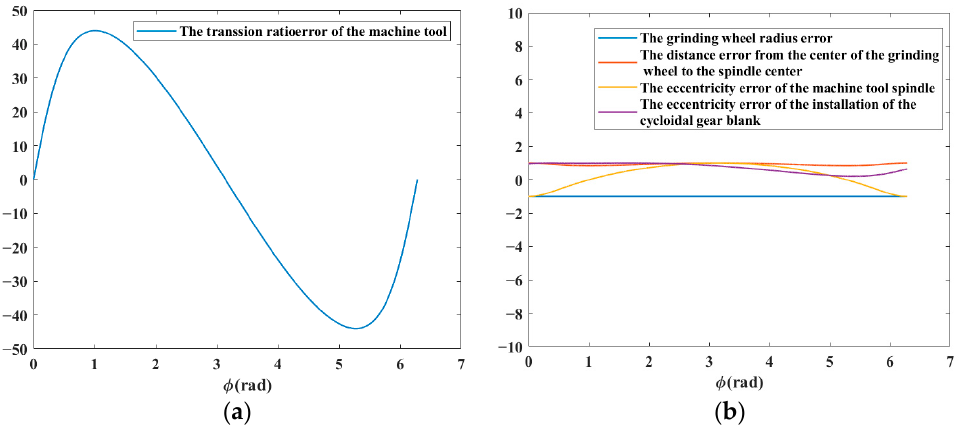
Figure 8. Sensitivity of cycloidal gear profile to various machining error items: ( a ) the transmission ratio error of the machine tool; ( b ) other error sources.